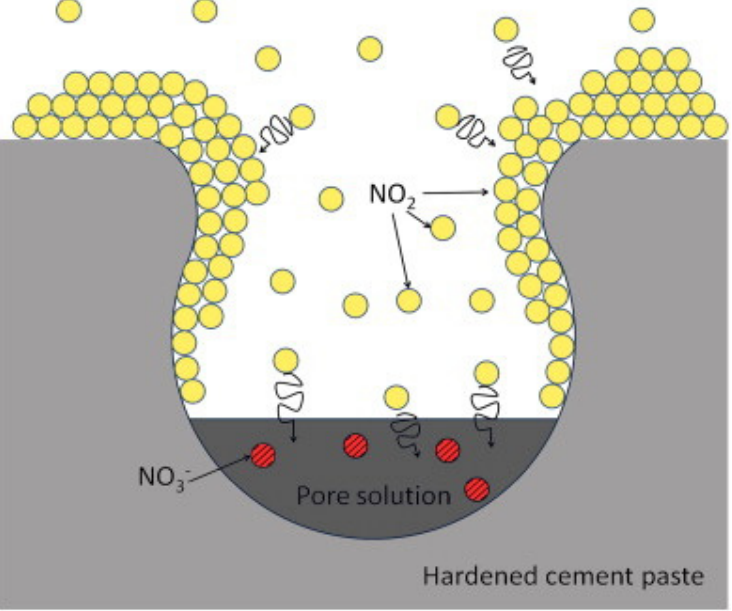
Figure 4. NO 2 adsorption on hardened cement paste, as well as into the pore solution [115] .